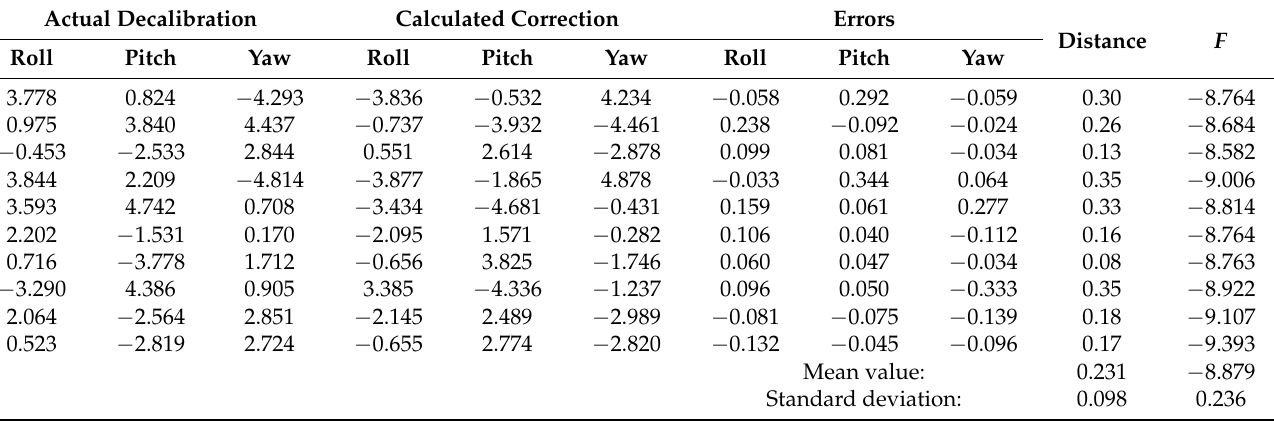
Table 2. Simulation of 10 decalibration experiments during a car movement, using correction refinement. Each row of the table corresponds to one experiment. Parameters: N 1 = 50, S = 10, N 2 =